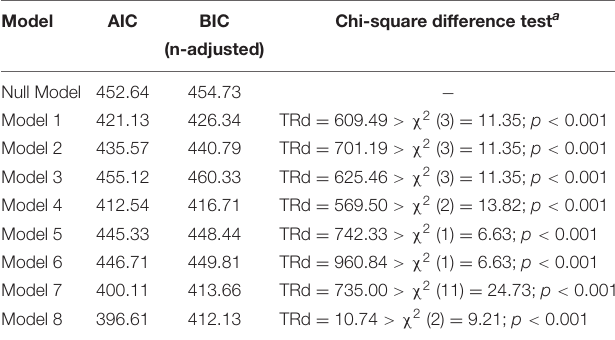
TABLE 4 | Model fit information for the six distinct and two combined logistic multi-level models predicting the risk to delay ( Y = 1) vs. work on a task ( Y = 0).